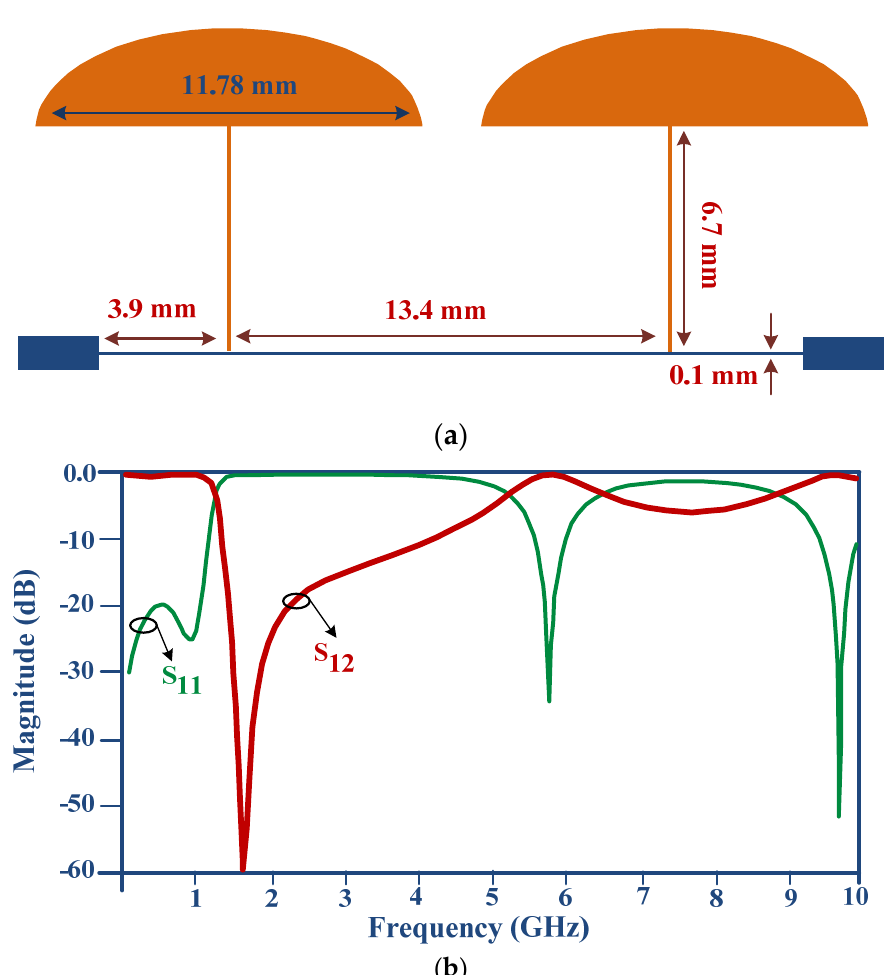
Figure 8. Two elliptical resonators’ ( a ) structure and ( b ) their frequency response.